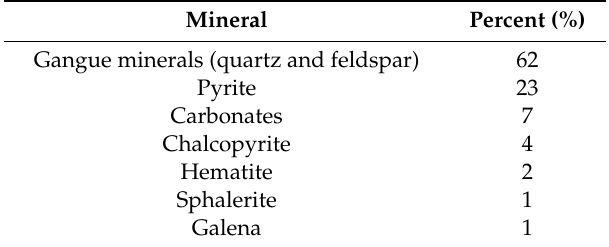
Table 1. Mineral composition of the gold ore from Íquira-Huila